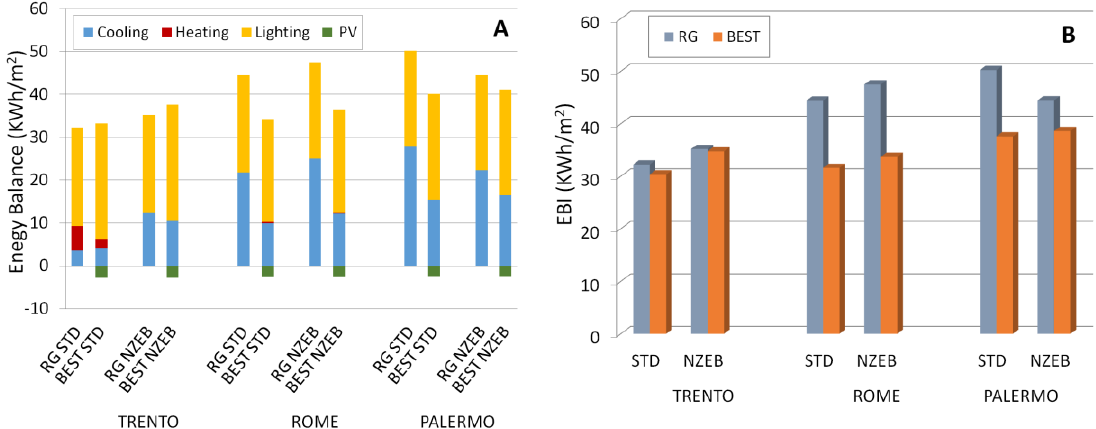
Figure 11. ( A ) Energy balance for the BEST solution compared to the reference glass (RG) of the STD and NZEB models at the N/S orientation of the building; ( B ) EBI index evaluated for the same exposure and glazing elements.